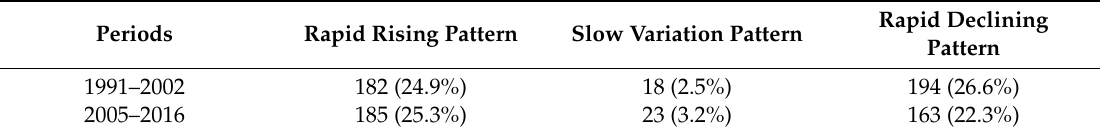
Table 2. The statistical results of three patterns during the two periods.